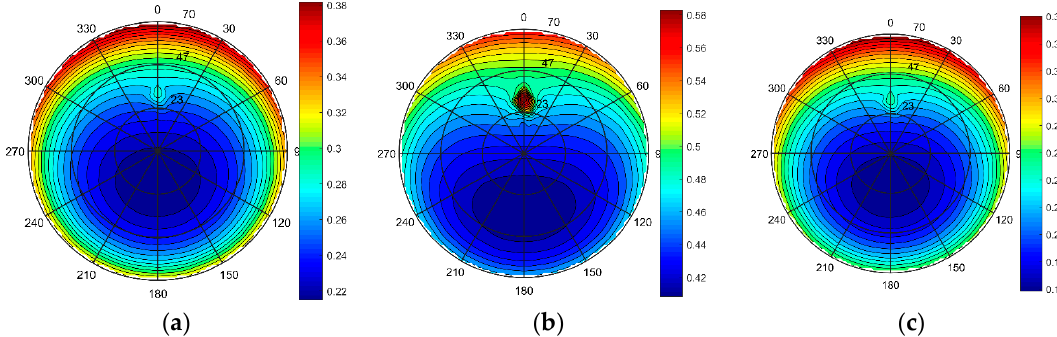
structures, solar angles, and soil backgrounds. The list of variables and their ranges are in Table 2.